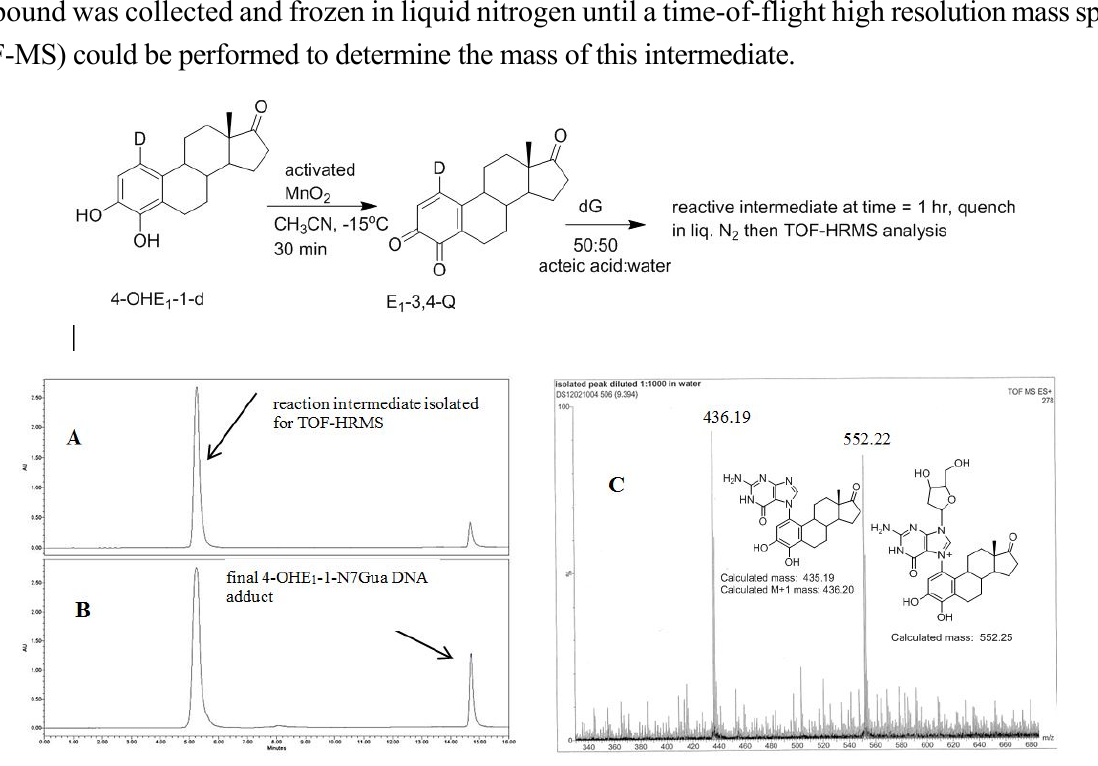
Figure 7. Oxidation of 4-OHE 1 -1-d to E 1 -3,4-Q-1-d and subsequent reaction with dG. ( A ) Reverse phase C-18 HPLC analysis after 1 h (B) Reverse phase C-18 HPLC analysis after 4 h ( C ) T OF-MS analysis of the early eluting peak in the positive ion